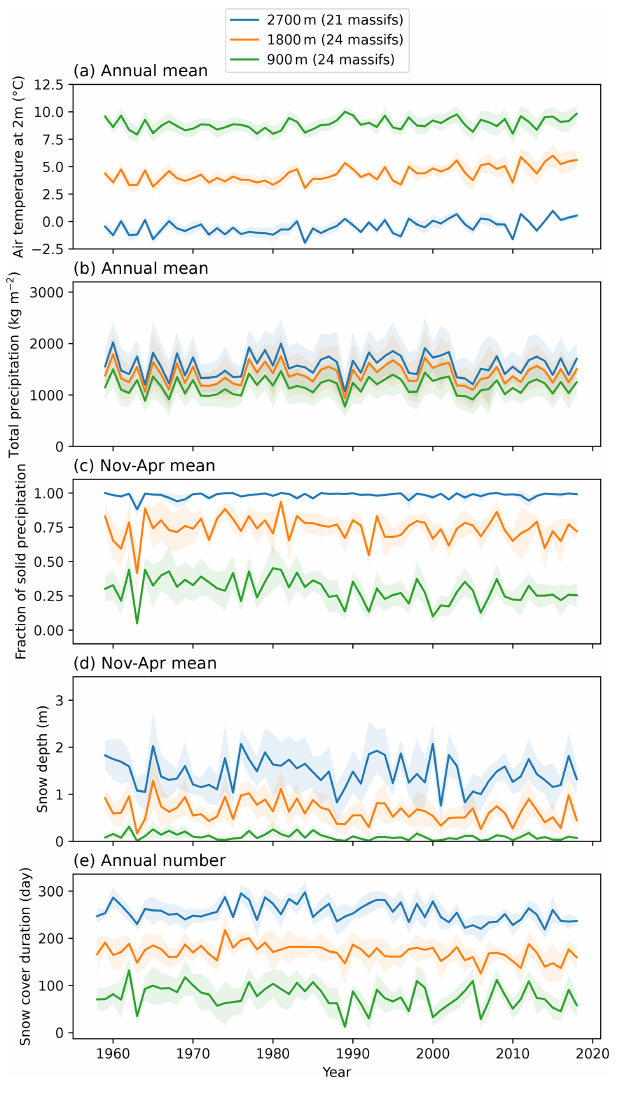
Figure 6. Evolution of the annual mean air temperature at 2m (a) , total precipitation (b) , winter (November to April) mean of the frac- tion of solid precipitation (c) , total snow depth (d) and snow cover duration (e) aggregated over all the massifs of the French Alps at different elevations. The shadings represents the variability between the massifs.